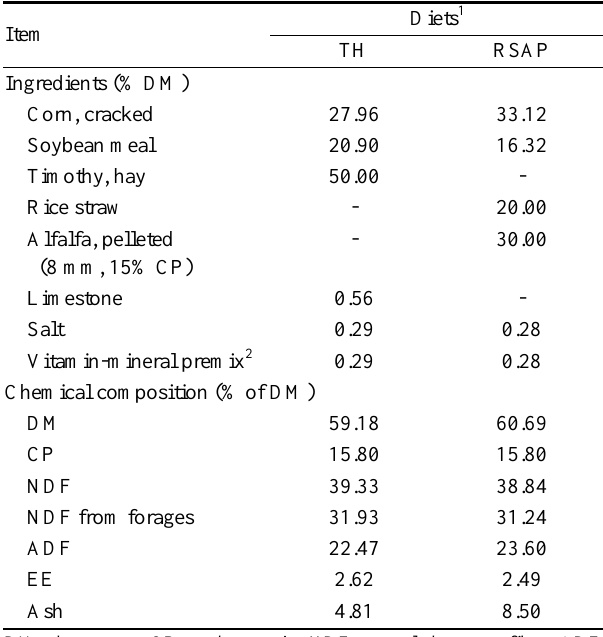
Table 1. Ingredients and chemical composition of experimental